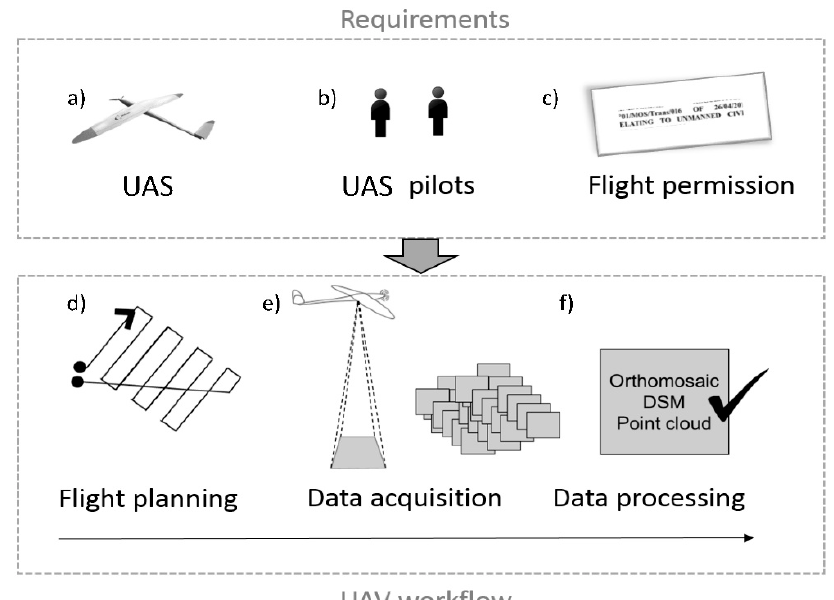
Figure 2. Unmanned Aerial Systems (UAS) data collection–requirements and data acquisition